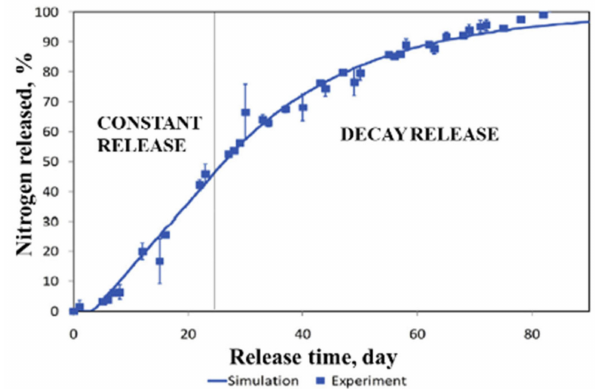
Figure 6. Release profile of Agrium. Reprinted with permission from [109]. Copyright 2015 Elsevier.